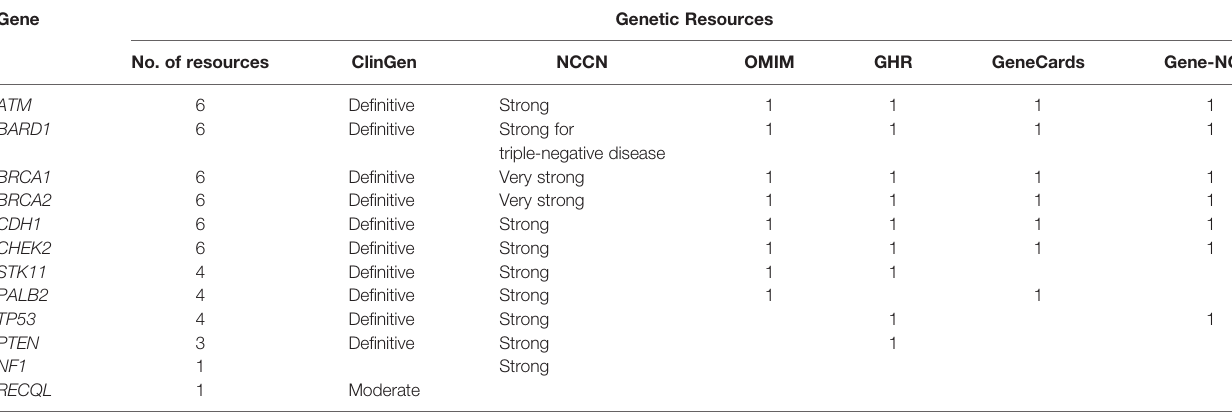
TABLE 1 | Associations between the 12 susceptibility genes and breast cancer in six genetic resources. Gene Genetic Resources